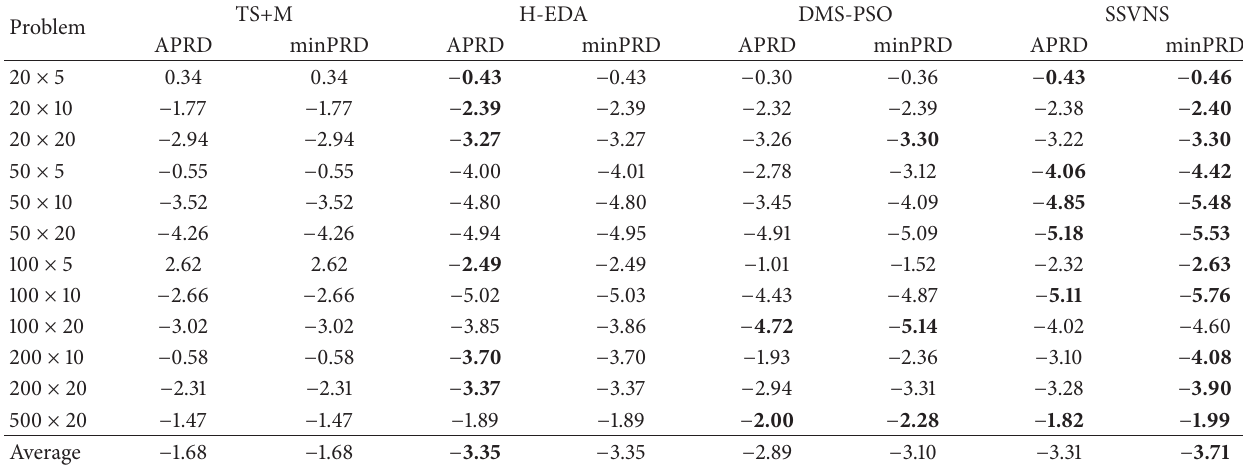
Table 2: Comparison results between SSVNS and the other powerful